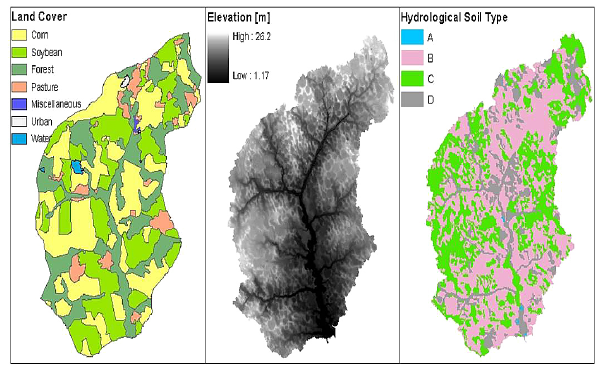
Figure 2. Characteristics of the study site (German Branch wa- tershed): land cover, elevation, and hydrologic soil group. Note: (1) Miscellaneous land cover indicates agricultural lands used for minor crops, vegetables, and fruits; (2) hydrologic soil group (HSG) is characterized as follows: Type A – well drained soils with 7.6–11.4mmhr − 1 (0.3–0.45inchhr − 1 ) water infiltration rate; Type B – moderately well drained soils with 3.8–7.6mmhr − 1 (0.15–0.30inchhr − 1 ) water infiltration rate; Type C – moderately poorly drained soils with 1.3–3.8mmhr − 1 (0.05–0.15inchhr − 1 ) water infiltration rate; Type D – poorly drained soils with 0– 1.3mmhr − 1 (0-00.05inchhr − 1 ) water infiltration rate; (3) the land cover map shown is obtained from 2008 National Cropland Data Layer (NCDL). The time series NCDL maps (not shown here) in- dicate the areas grown with corn/soybean rotation are similar to the areas grown with soybean/corn